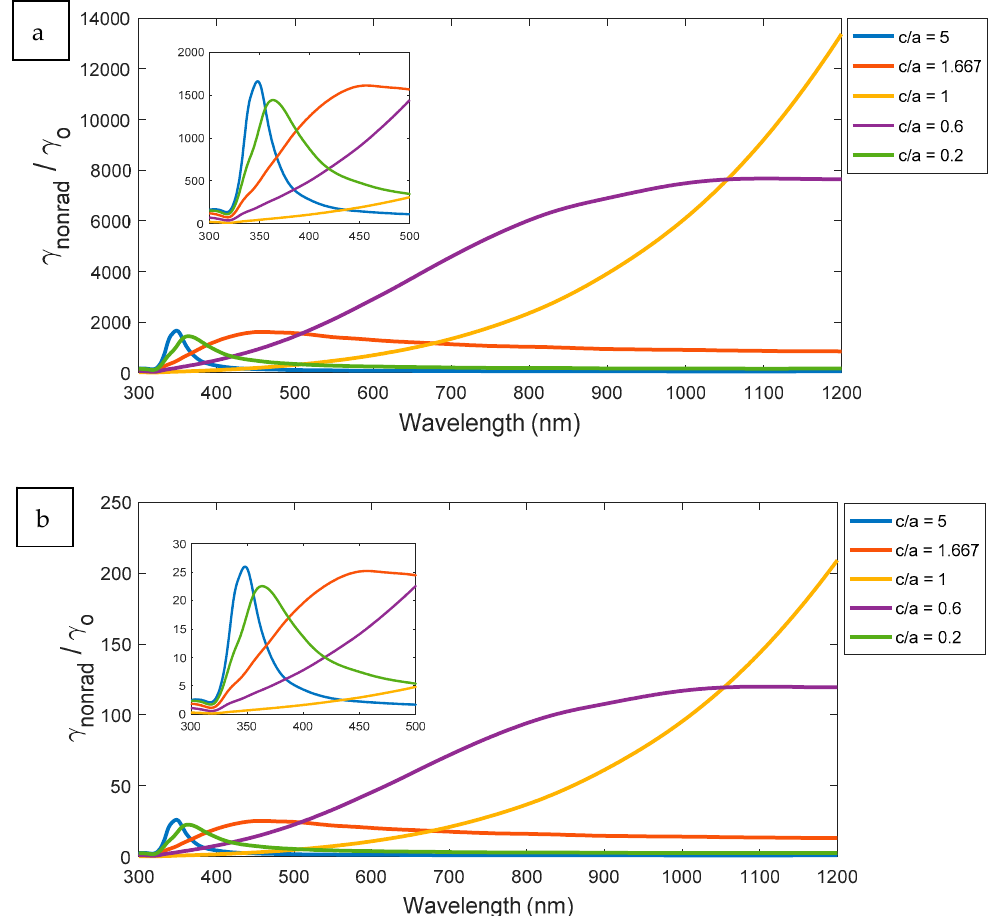
Figure 9. The Non-radiative decay rate for all aspect ratios at different dimension: ( a ) d = 5 and ( b ) d = 20 nm.